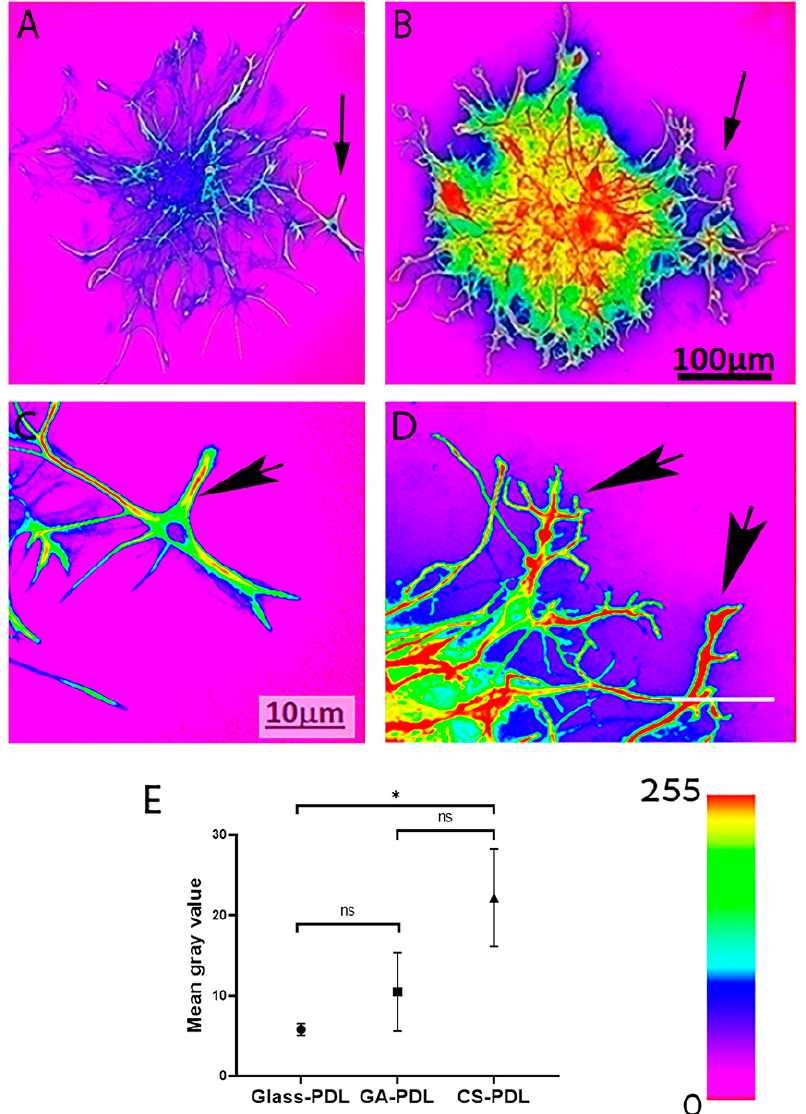
Figure 5. CS-PDL elevates GFAP expression in migrating astrocytes. Color-coded GFAP fluorescent images. ( A ) Glass-PDL. ( B ) CS-PDL. Arrows point to enlargement areas ( C , D ), respectively. Arrows in ( C , D ) point to growth cones. ( E ) Quantification of GFAP expression level. Student’s t -test: Glass-PDL N = 3, Mean = 5.81 ± 0.74, GA-PDL N = 3, Mean = 10.49 ± 4.89, t 2.092 = − 1.640, P = 0.237, CS-PDL N = 3, Mean = 22.18 ± 6.06, t 2.060 = − 4.639, P Two-tailed = 0.041. GA-PDL vs. CS-PDL: t 4 = − 2.597, P Two-tailed = 0.060. Scale: ( A , B ) — 100 µ m; ( C , D ) — 10 µ m. (* P < 0.05; ns = non-significant). Astrocytes also reacted to contact with the aragonite matrices by elevating GFAP expression